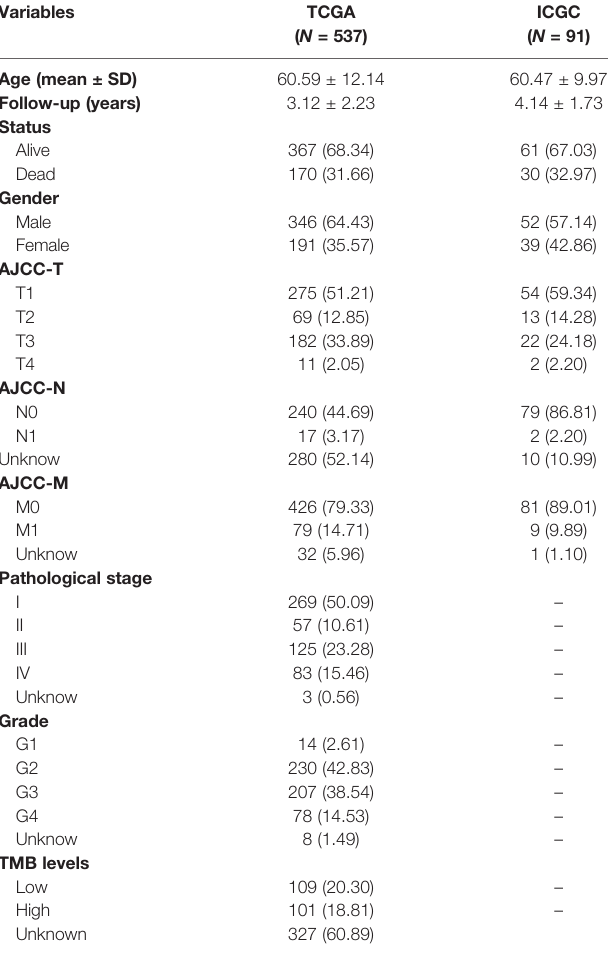
TABLE 1 | Clinical characteristics of all 618 ccRCC patients included in this study.